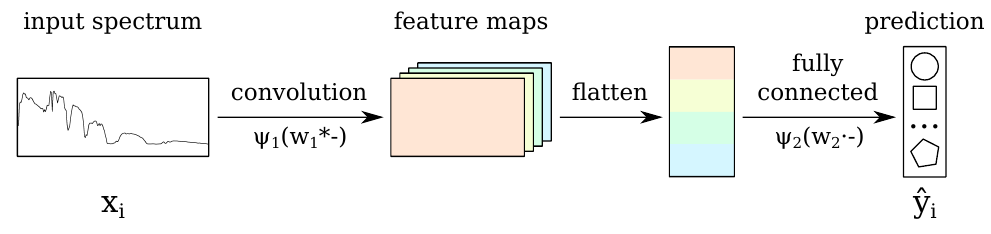
Figure 2. Single hidden convolutional layer CNN architecture. The input of the CNN is the spectral feature vector of a pixel to which 1D convolutions are applied in the convolutional layer. Afterwards, the resulting feature maps are flattened and fed to the last, fully-connected, layer, which outputs the class prediction of the input